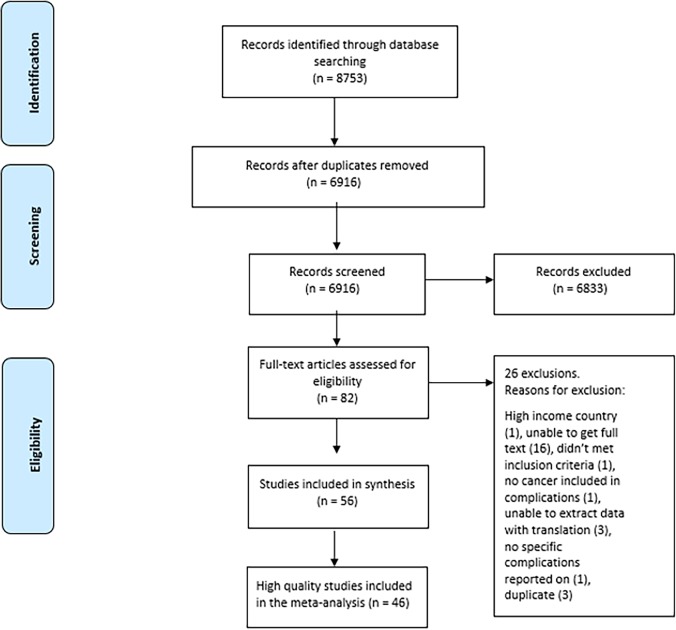
PRISMA flowchart.